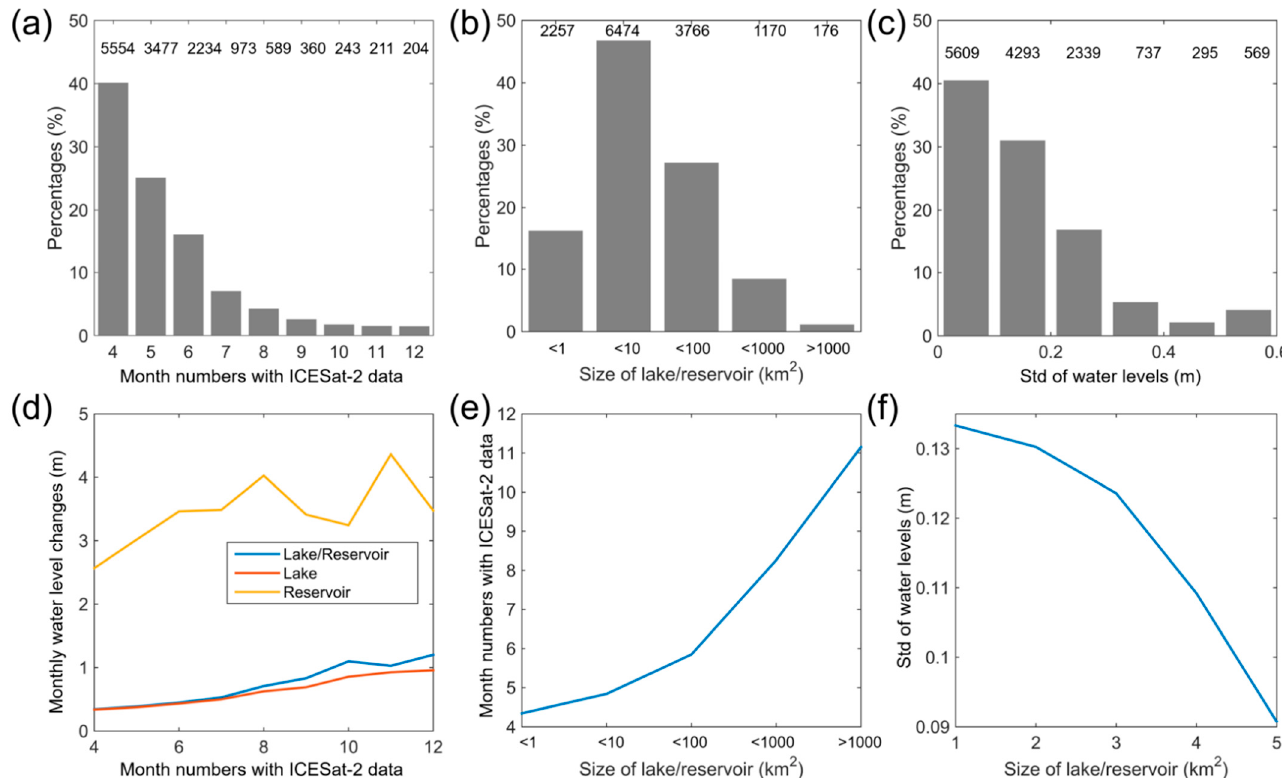
Figure 4. Global assessment of monthly water level changes of lakes and reservoirs derived from ICESat-2 ATL13 products. Percentage distributions of the number of months with ICESat-2 data ( a ), lake/reservoir sizes ( b ), and standard deviation (Std) of water levels ( c ) for global lakes and reservoirs; ( d ) relationship between the number of months with ICESat-2 data and derived monthly water level changes; ( e ) relationship between the lake/reservoir sizes and number of months with ICESat-2 data; and ( f ) relationship between the lake/reservoir sizes and Std of water levels. Note that the specific number of lakes/reservoirs is given at the top of each histogram in ( a – c ).